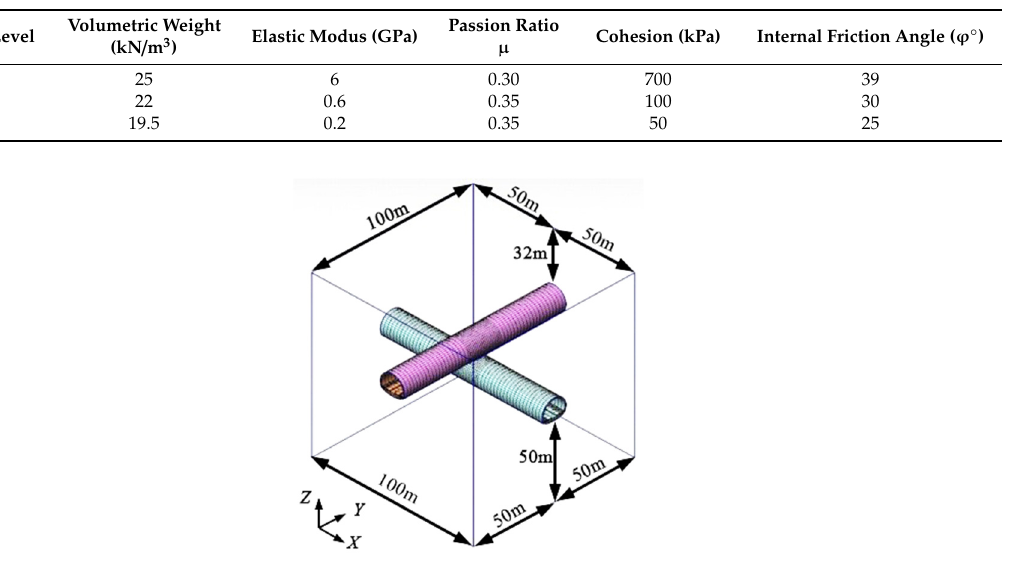
Figure 2. Schematic diagram of cross tunnels.